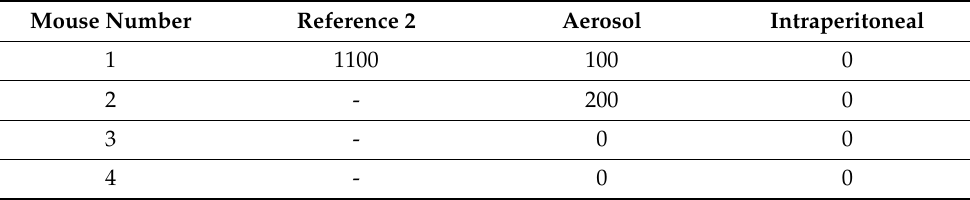
Table 11. The data of bacteriological examination (CFU/mL) of the animals that survived after observation for 9